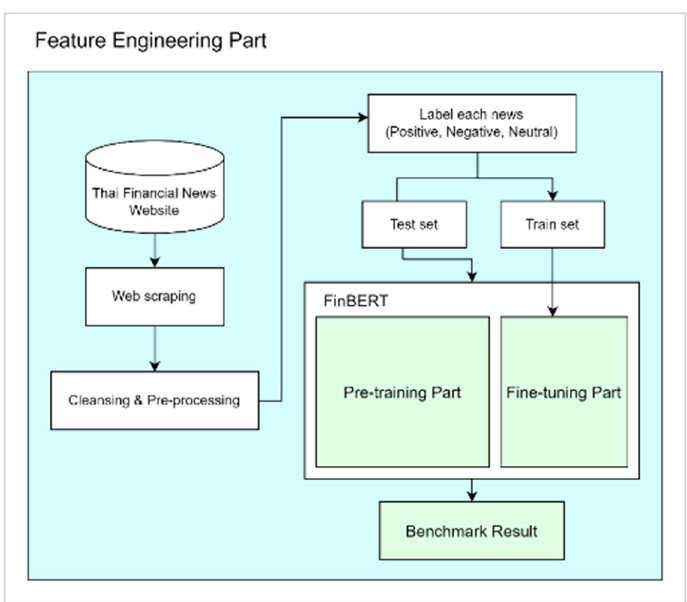
Figure 4. A sentiment analysis modeling process.